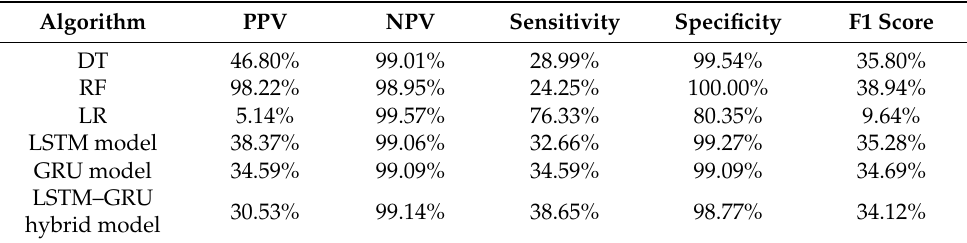
Table 8. Performance evaluation of shallow and deep learning. The highest PPV was DT, highest NPV was LR, highest sensitivity was LR, highest specificity was RF, and highest F1 score was RF. Algorithm